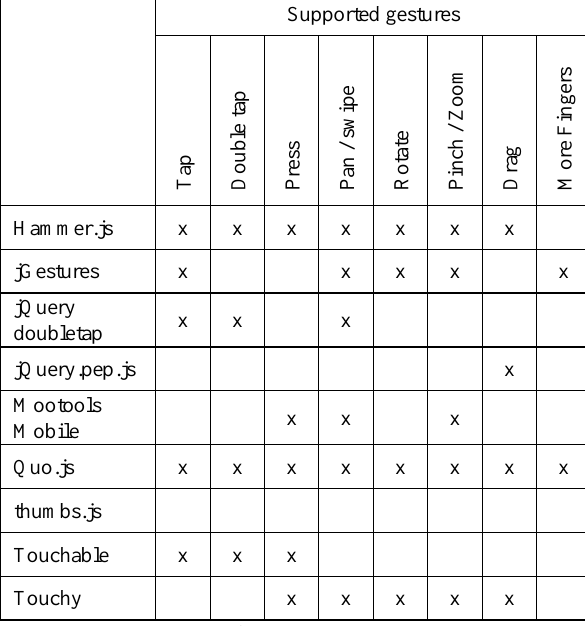
Tab. 1. Implementation of basic gestures in Java Script